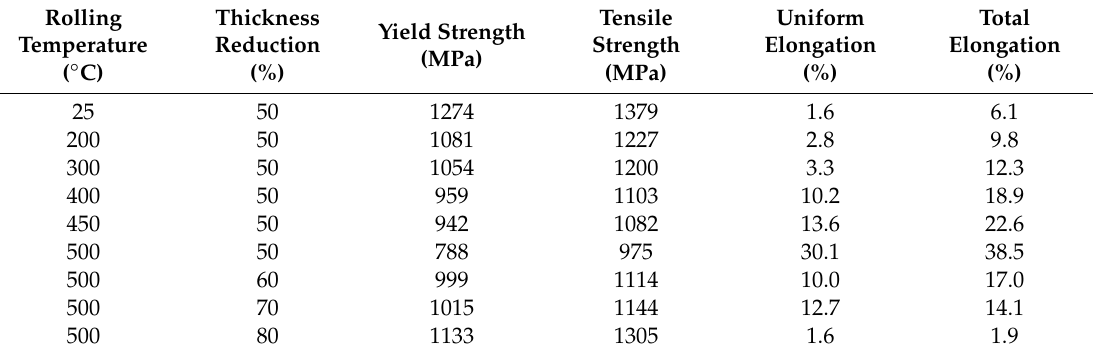
Figure 6. Engineering stress-strain curves of the investigated Fe-23Mn-0.3C-1Al steel subjected to varying rolling procedures. Table 4. Mechanical properties of the investigated Fe-23Mn-0.3C-1Al steel depending on rolling temperature and thickness reduction.